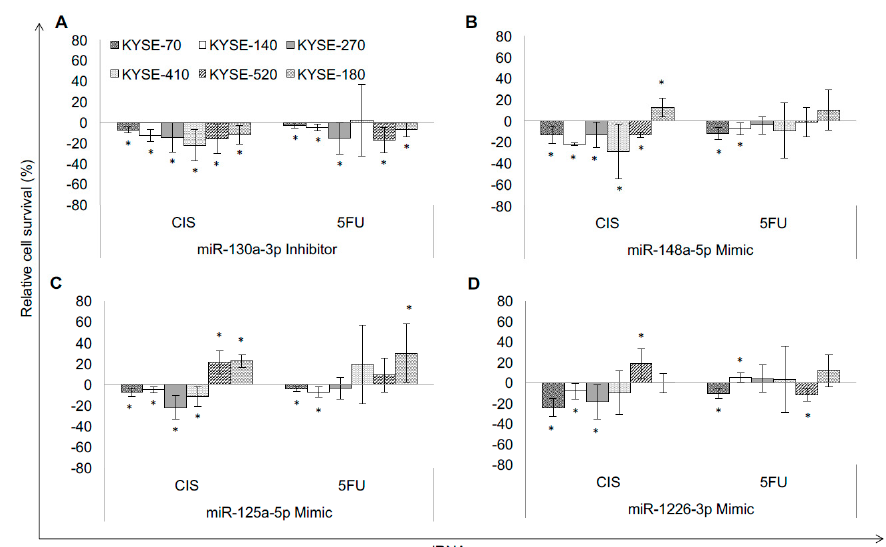
Figure 1. Specific miRNA signatures of resistant esophageal squamous cell carcinoma (ESCC) cell lines are responsible for chemotherapy resistant phenotypes. Effect of miRNA modulation on cytotoxicity after chemotherapy treatment: ( A ) miR-130a-3p Inhibitor; ( B ) miR-148a-5p Mimic; ( C ) miR-125a-5p Mimic; ( D ) miR-1226-3p Mimic. Relative cell survival compared to controls given in %, controls set to “zero”. K70: KYSE-70, K140: KYSE-140, K270: KYSE-270, K410: KYSE-410, K520: KYSE-520, K180: KYSE-180, CIS: cisplatin, 5-FU: 5-fluorouracil; * significance ( p ≤ 0.05).